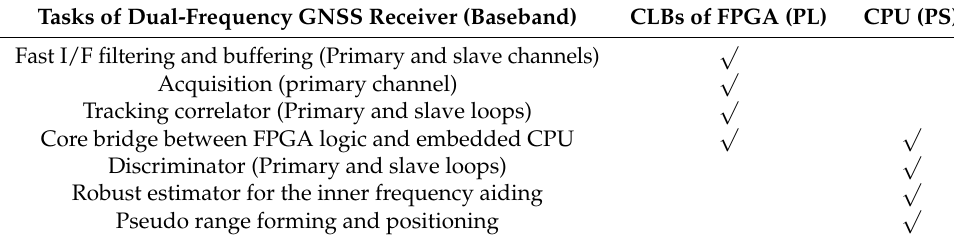
Table 1. Algorithm partition on the FPGA. Tasks of Dual-Frequency GNSS Receiver